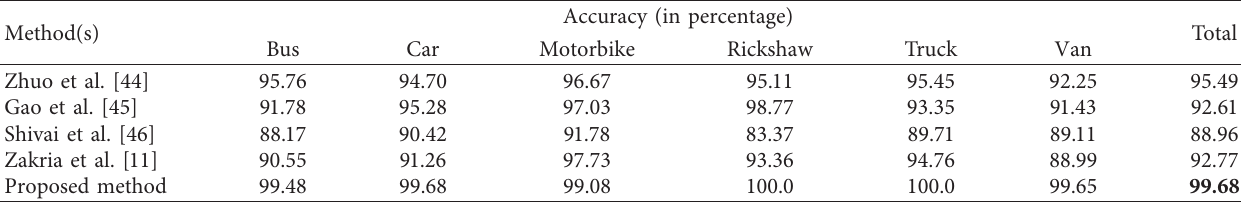
Table 6: Comparison of the proposed method with existing state-of-the-art vehicle classification